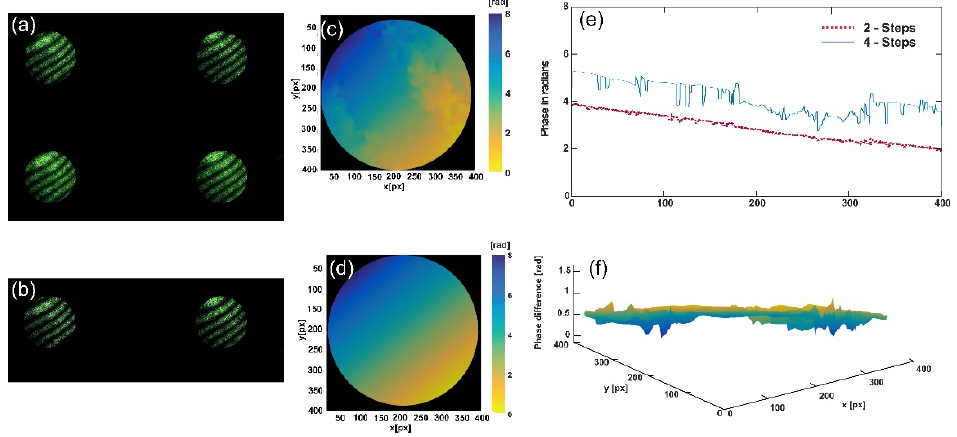
Figure 9. Red blood cells. ( a , b ) Four simultaneous patterns. ( c ) Wrapped phase. ( d ) Phase map ( e ). Transversal section of RBC.